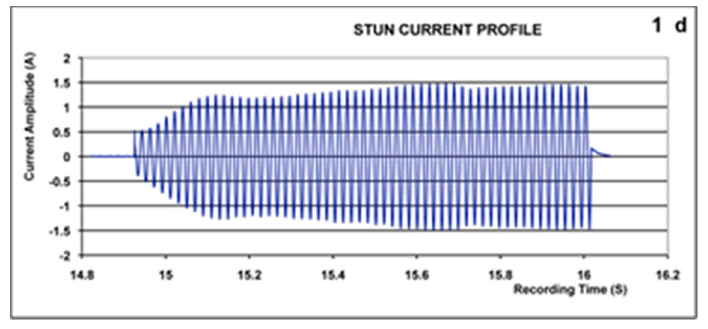
( d ) Correct profile of turkey #6 of Table 7. Figure 1. The EEG, FFT(Fast Fourier transform, an indicator of total power content) analysis, voltage, and current profiles from Turkey #6 from Table 7.